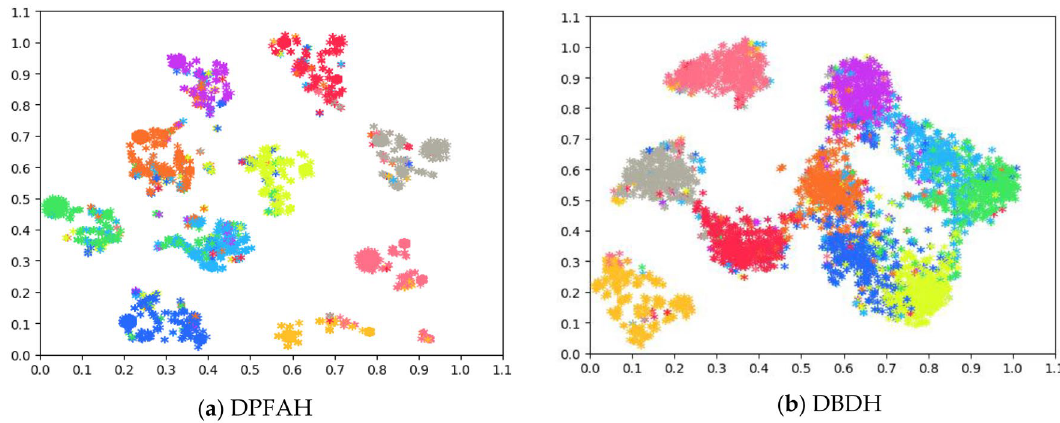
Figure 7. ( a,b ) Present the t-SNE visualization of hash codes on CIFAR-10. (Created by “python3.6” https:// www. python. org/ downl oads/ relea se/ python- 3614).